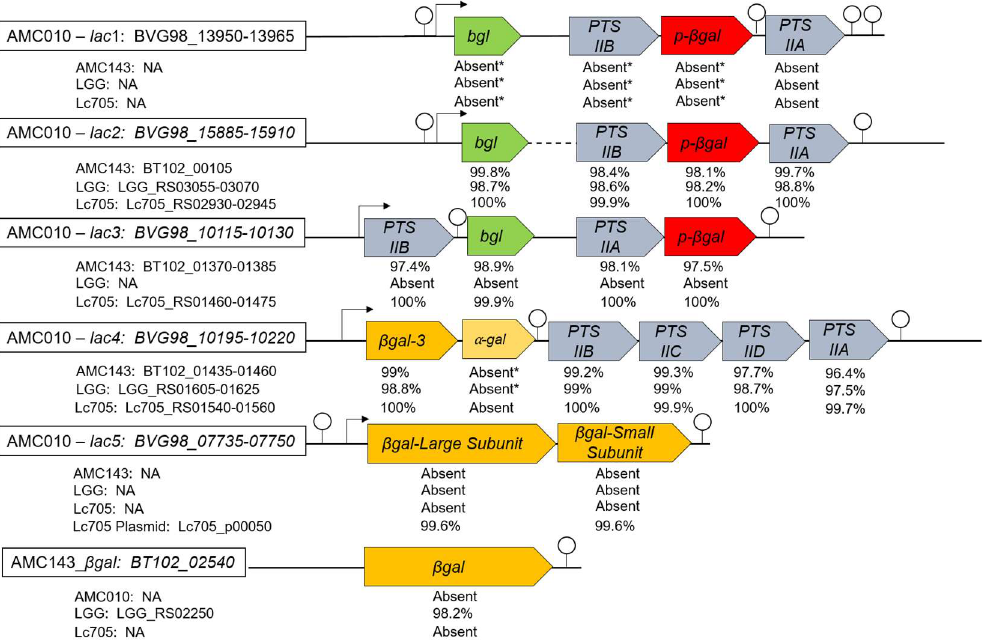
Figure 1. Comparative genomic of lactose metabolism operons in Lactobacillus rhamnosus . Genomes were analyzed using Geneious software, comparing operon organization and nucleotide identity between the human isolates AMC010, AMC143, LGG, and the dairy isolate Lc705. Promoters were identified using the BPROM (Softberry, Bangkok, Thailand) promoter prediction tool [48]. Terminators were identified using the ARNold terminator prediction tool [49]. * Genes showed >60% identity to homologs in lac2 operon; bgl: beta glucoside antiterminator; PTS: phosphotransferase system; NA: not applicable.